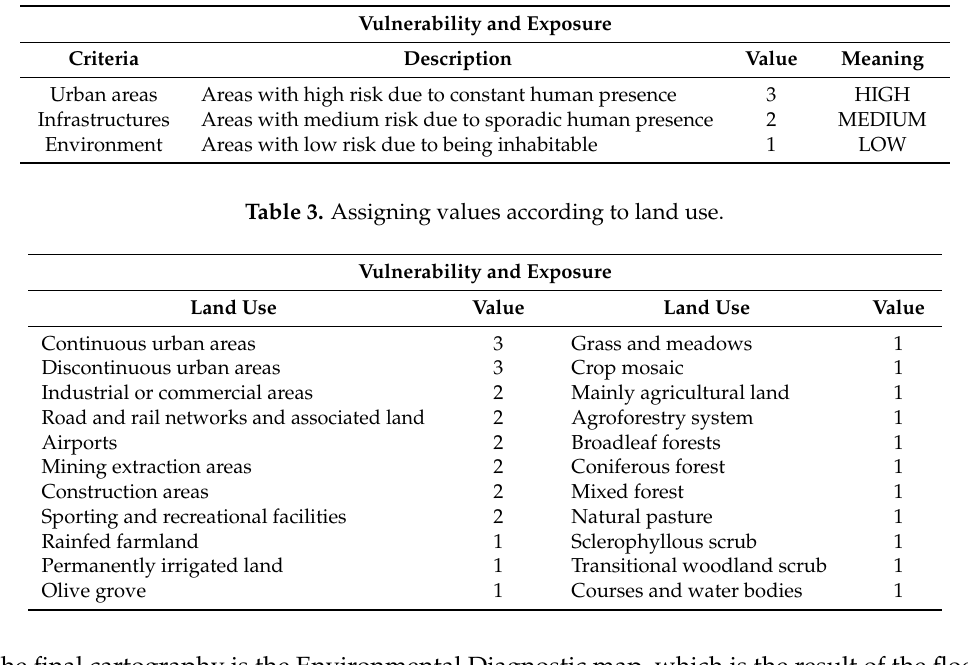
Table 2. Criteria for assessing different land uses.